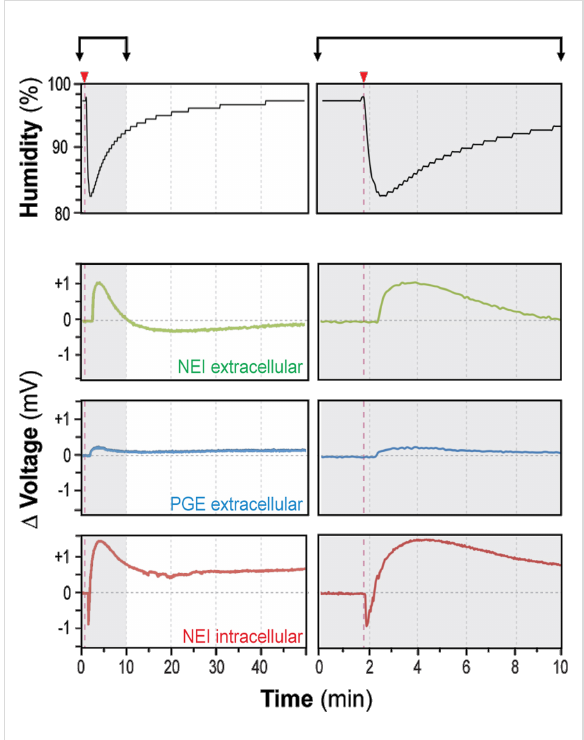
Figure 4: Physarum p. -based, autonomous humidity sensing. Physarum p. sandwiched between NEI/PGE or PGE/PGE surfaces was exposed to changes in incubator humidity (black) using a custom- built ventilation system (see Supporting Information File 1). Briefly, transient drops in humidity evoked selectively in NEI/PGE electrodes with negative potentials (indicative of intracellular, nanoelectrode local- ization) a biphasic response (red), consisting of a short hyperpolariza- tion and longer depolarization phase. PGEs (blue) or “extracellular” NEI/PGEs (green) showed instead a delayed monophasic response to transient decreases in humidity. Representative recordings are